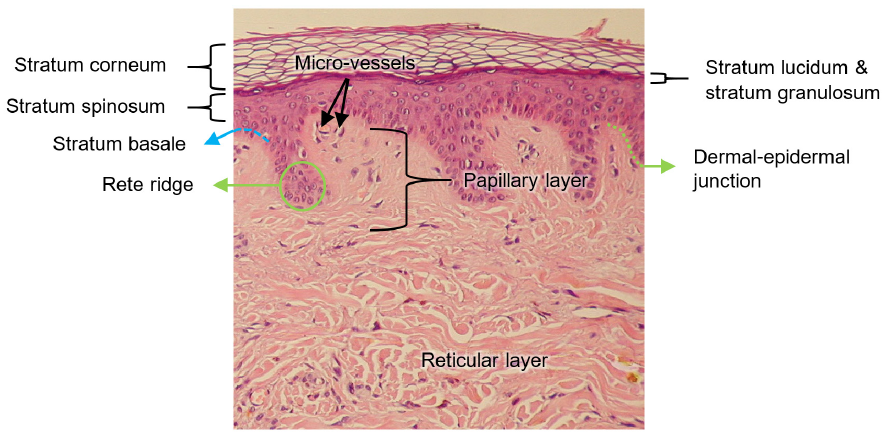
Figure 3. Illustration of the different layers that compose the human skin. Based on [59].